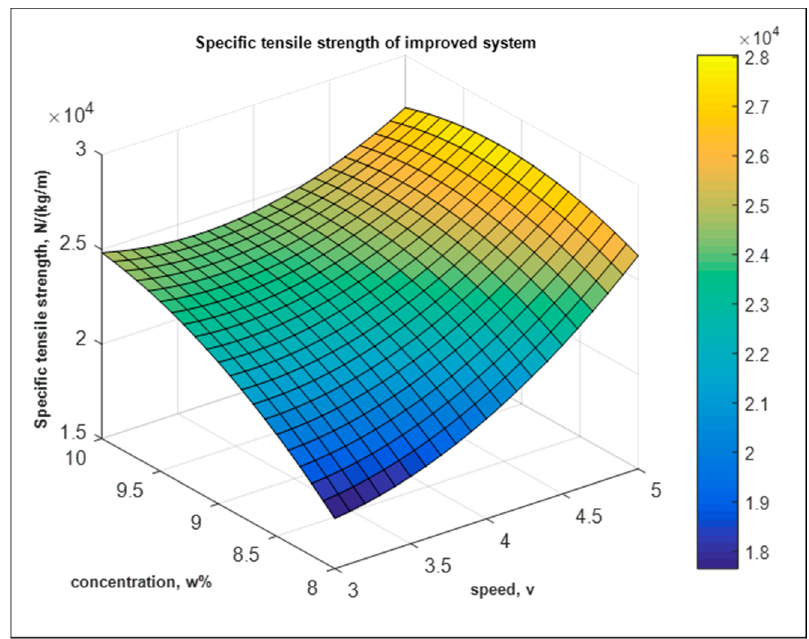
Figure 24. Fitted model of specific tensile strength from improved system.